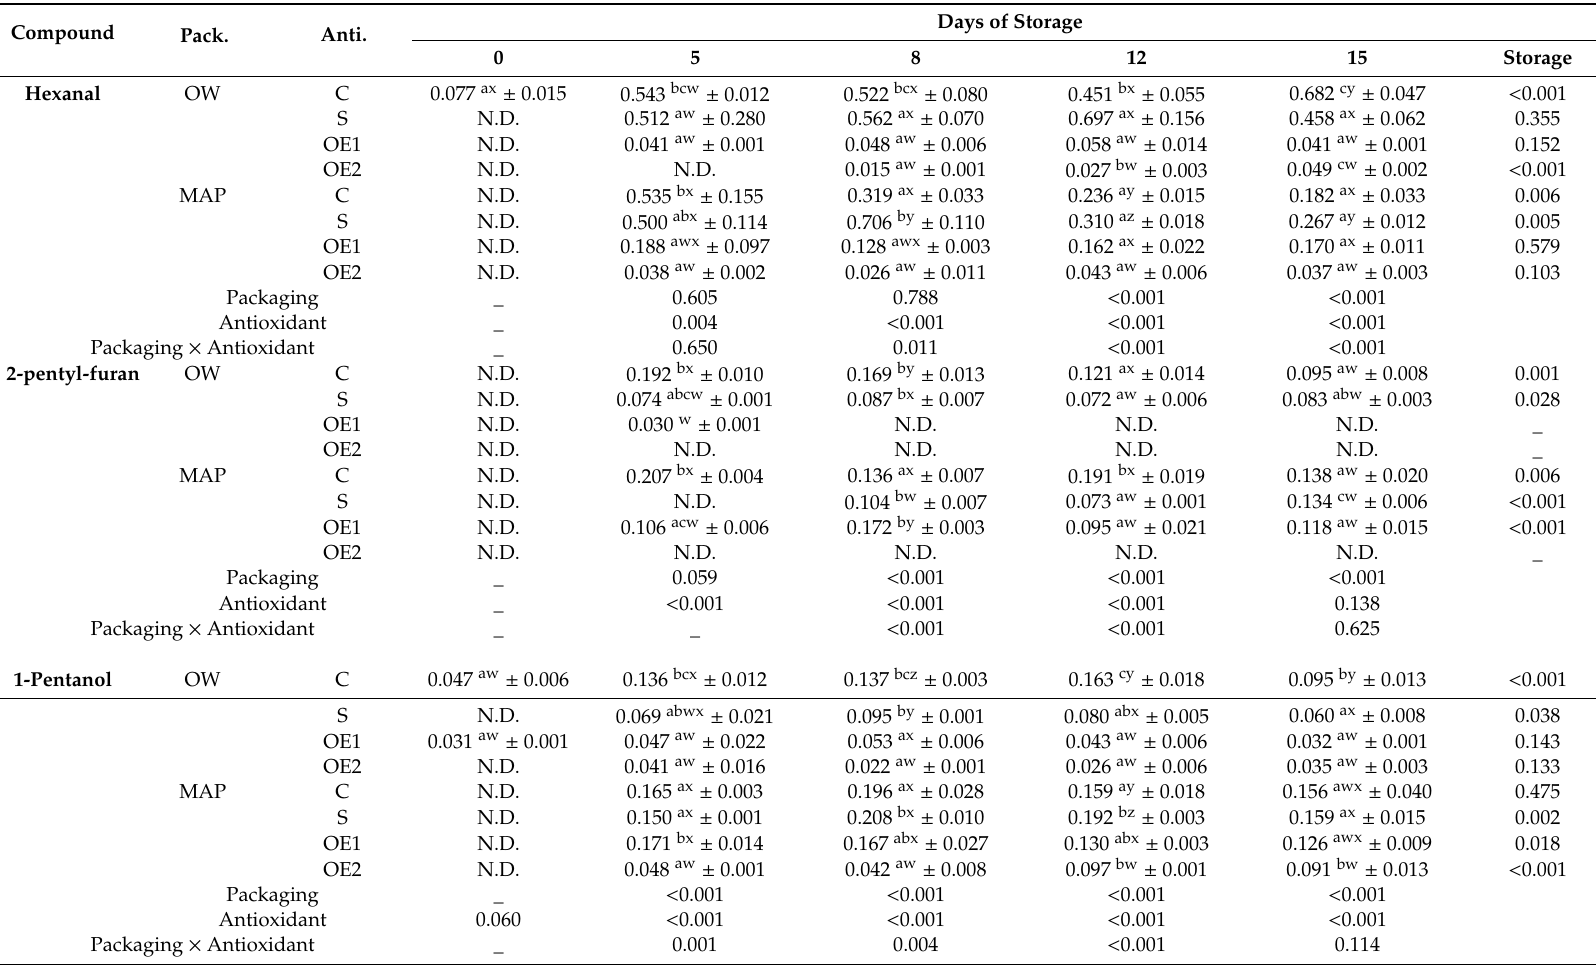
Table 8. The volatile organic compounds (in area accounts × 10 − 6 , arbitrary units) of beef patties with di ff erent formulations packed under di ff erent conditions during storage at 4 ◦